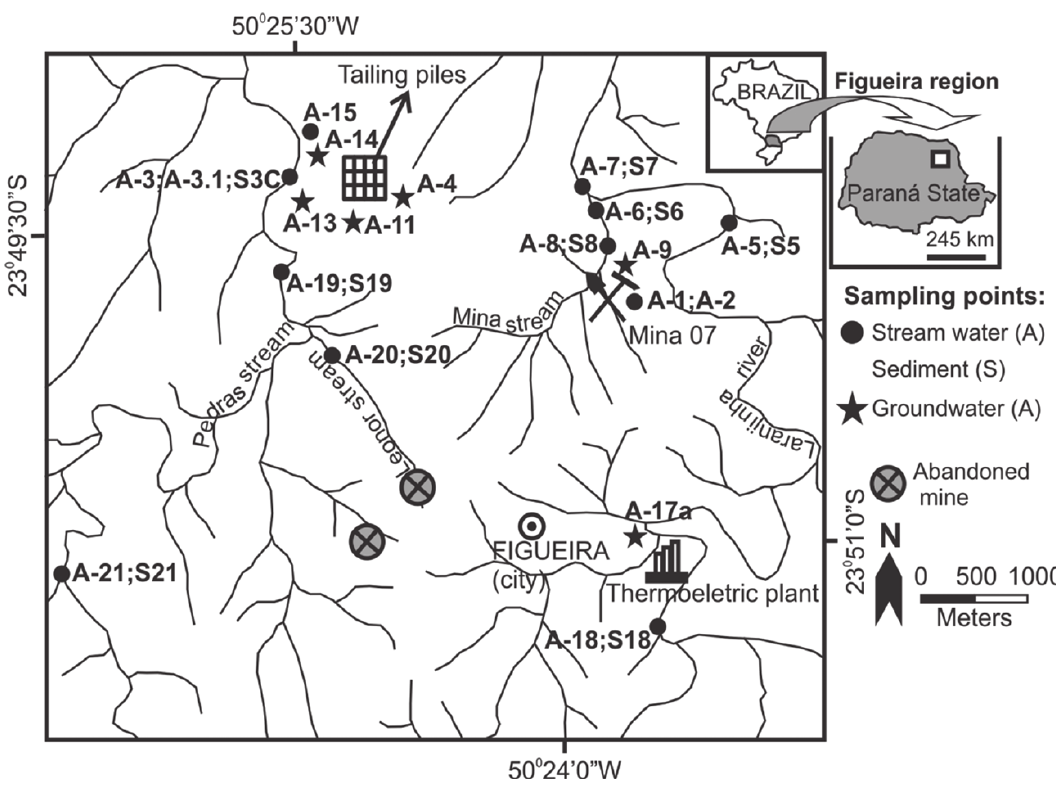
Figure 1 − Location of the sampling points in the study